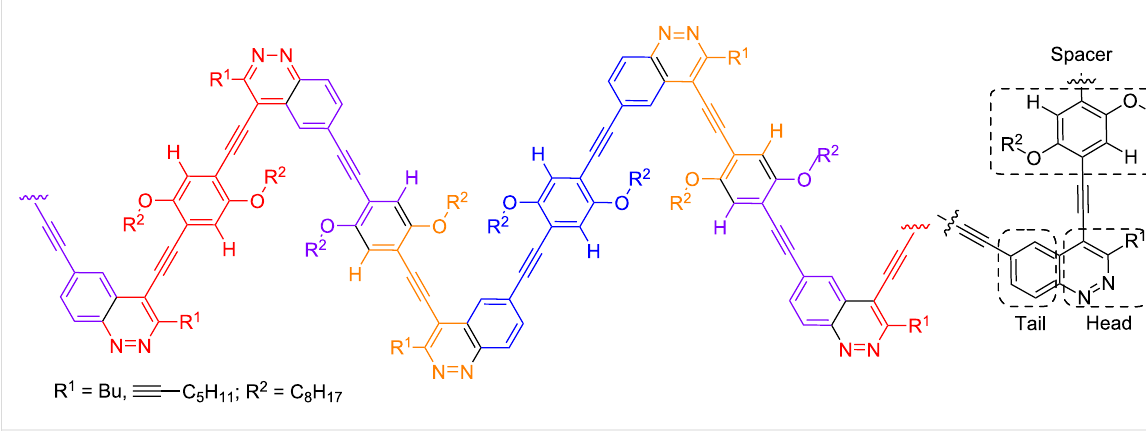
(orange–purple) oriented cinnoline units in the irregular PAEs chains (Figure 5). Moreover for the hydroquinone moiety that connects head-to-tail oriented cinnoline units (orange–purple) the additional splitting was observed (for zoom copies of NMR spectra see Supporting Information File 2).